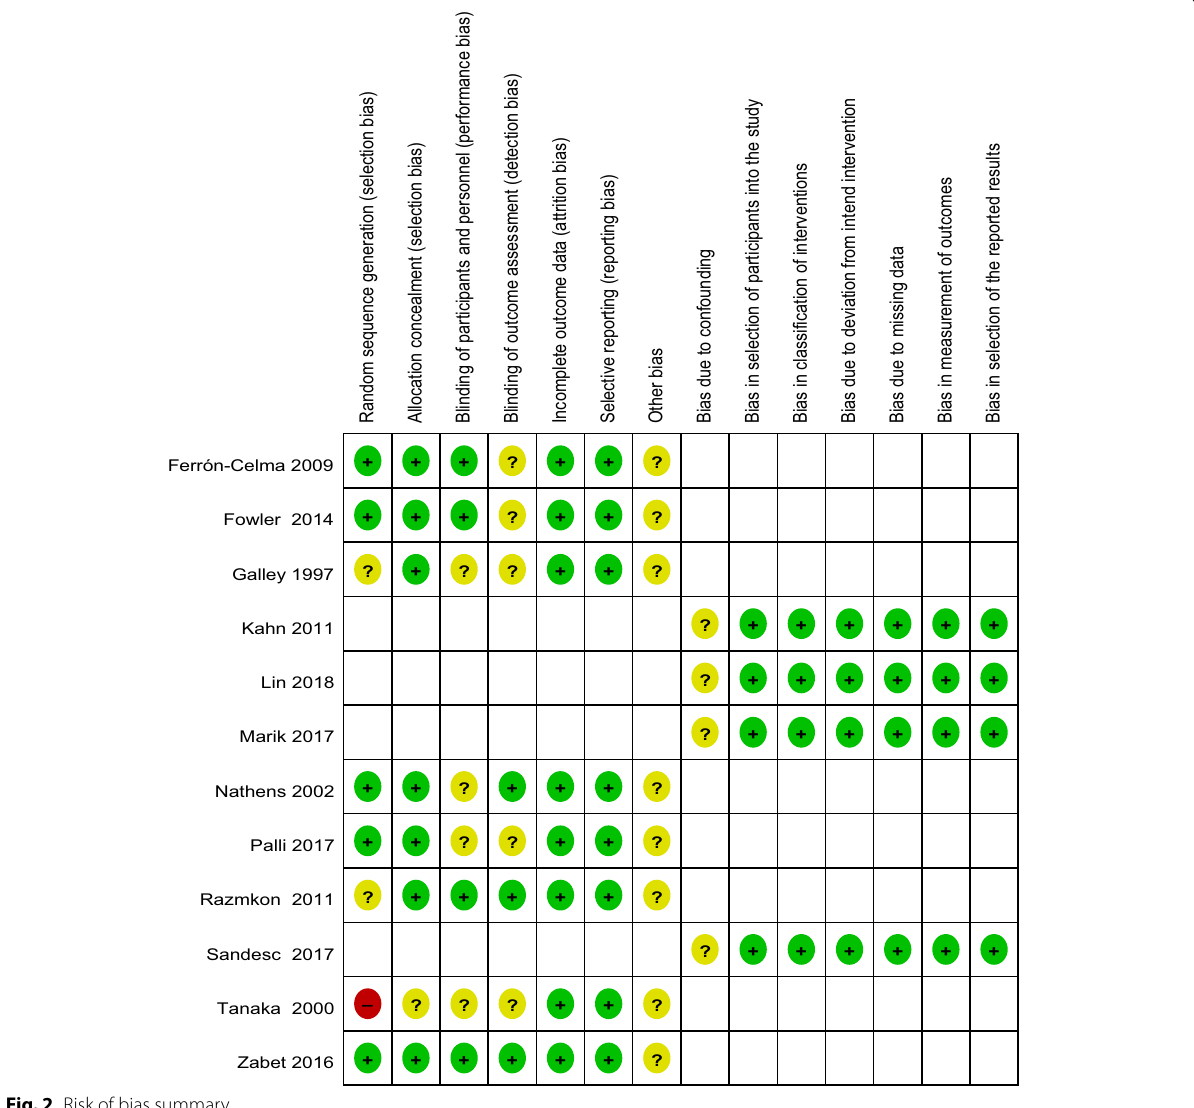
Fig. 2 Risk of bias